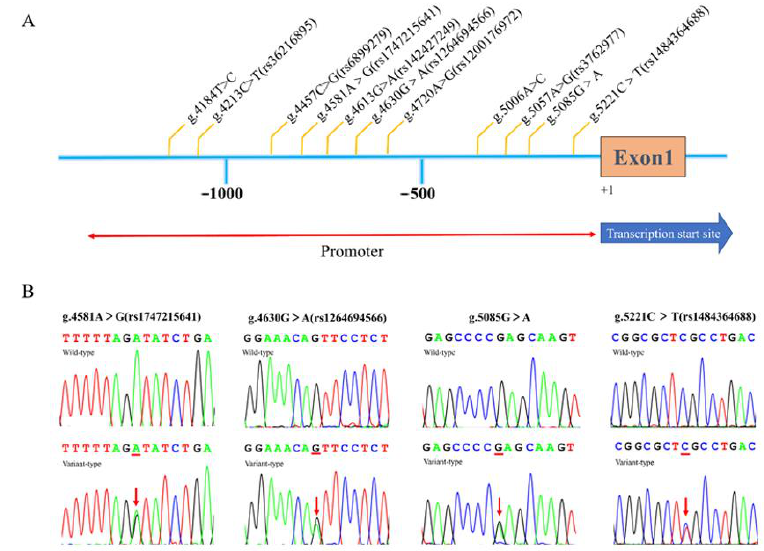
Figure 2. Identified variants of ISL1 gene. ( A ) The locations of eleven variants identified within the ISL1 gene promoter region in this study. The genetic variants were named according to the genomic DNA sequence of human ISL1 gene (Genbank accession number NG_023040.1). ( B ) The sequencing chromatograms of the variants only found in patients with TOF. For all heterozygous variants [g.4581A > G(rs1747215641), g.4630G > A(rs1264694566), g.5085G > A, g.5221C > T(rs1484364688)], the top panel shows the wild − type and the bottom panel shows the variant-type. The variant site is labeled with the red line and arrow. Table 2. Variants within the ISL1 gene promoter in TOF patients and controls.